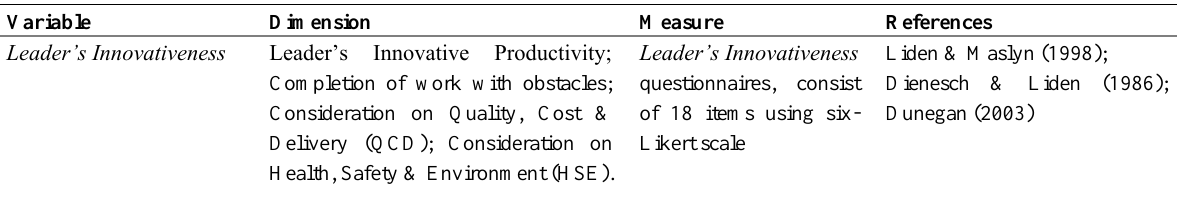
Table 1: Measure of Variables